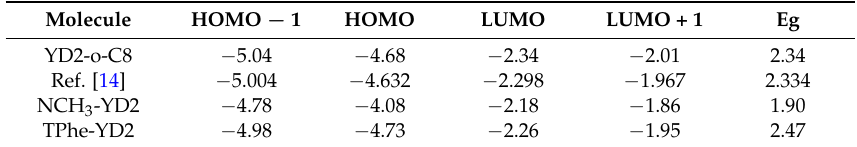
Table 3. The calculated frontier molecular orbital energies (eV) and HOMO-LUMO energy gap (Eg, eV) of dyes, together with available calculated values